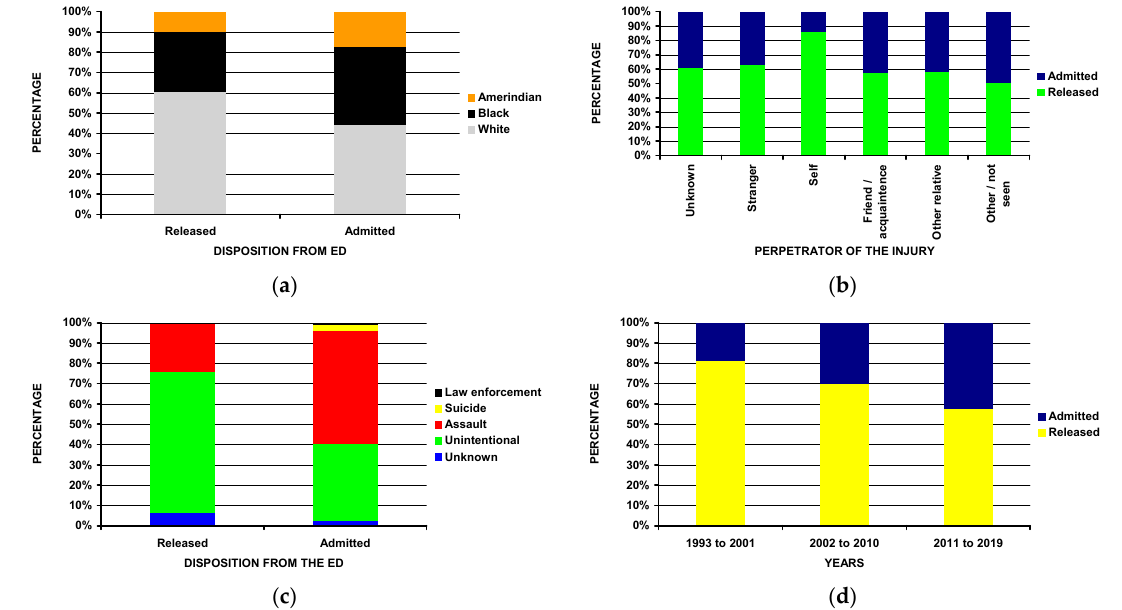
Figure 5. Differences by disposition from the ED: ( a ) by race ( p = 0.011); ( b ) by perpetrator of the injury ( p = 0.0006); ( c ) by intent of the injury ( p < 10 − 4 ); ( d ) by year time span ( p =